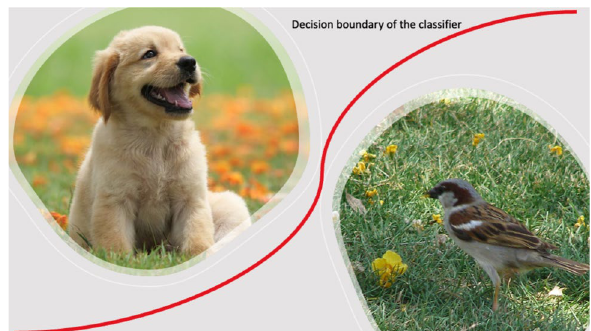
Fig. 5 Classifying Bird and Dog